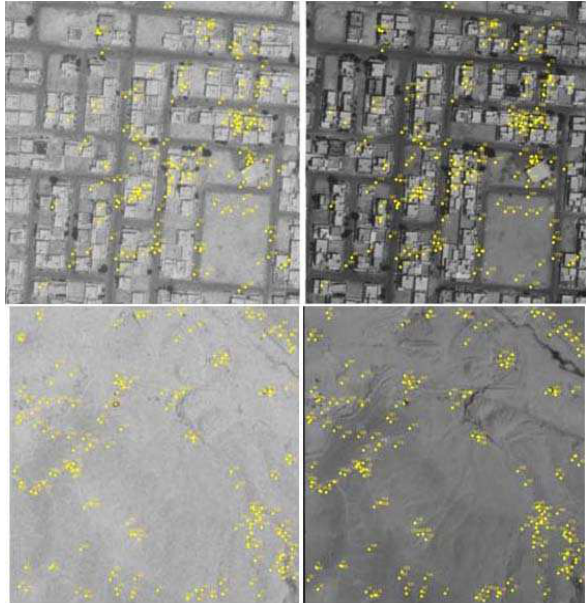
Figure 6. Sample of identified tie points, above urban, below rural, left GeoEye-1, right aerial